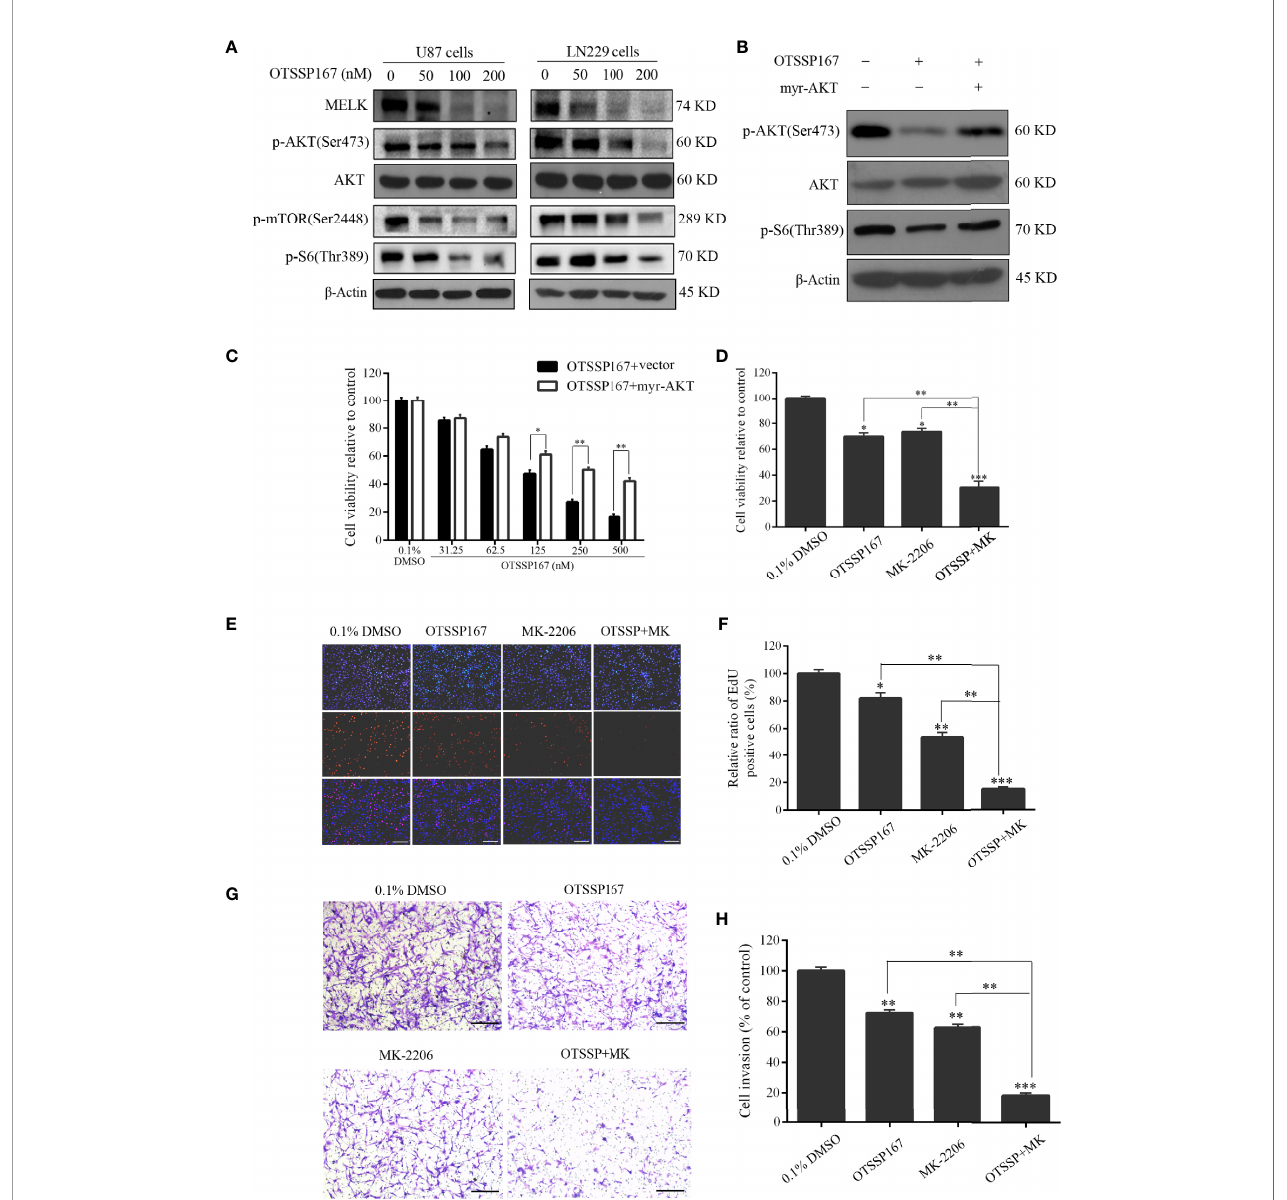
FIGURE 4 | OTSSP167 reduces MELK protein expression and blocks AKT pathway activation, thereby inhibiting the proliferation and invasion of GBM cells. (A) U87 and LN229 cells were treated with OTSSP167 for 24 h. Western blotting showing the expression levels of MELK, p-AKT(Ser473), AKT, p-mTOR(Ser2448), and p-S6 (Thr389) proteins. (B) U87 cells transfected with myr-AKT plasmid were treated with OTSSP167, followed by western blotting to assess changes in p-AKT(Ser473), AKT, and p-S6(Thr389) expression. (C) CCK-8 assay shows the effects of OTSSP167 treatment on U87 cells transfected with myr-AKT plasmid compared to the control group. (D) CCK-8 assay showing the viability of U87 cells treated with 50 nM OTSSP167 and 1 m M MK-2206 (AKT inhibitor) alone or combined OTSSP167 and MK-2206 treatment for 72 h. (E) Measurement of cell proliferation after treating with 50 nM OTSSP167 and 1 m M MK-2206 alone or their combinations by EdU incorporation assay. (F, H) Quantitative analysis of proliferative and invading cell numbers. The numbers of proliferative and invading cells were normalized to that of the control group. (G) U87 cells were incubated with 50 nM OTSSP167 and 1 m M MK-2206 alone or their combinations. Cell invasive abilities were evaluated by transwell assay. Results were expressed as means ± SEM of three independent experiments. * P < 0.05, ** P < 0.01 and *** P < 0.001 compared with control